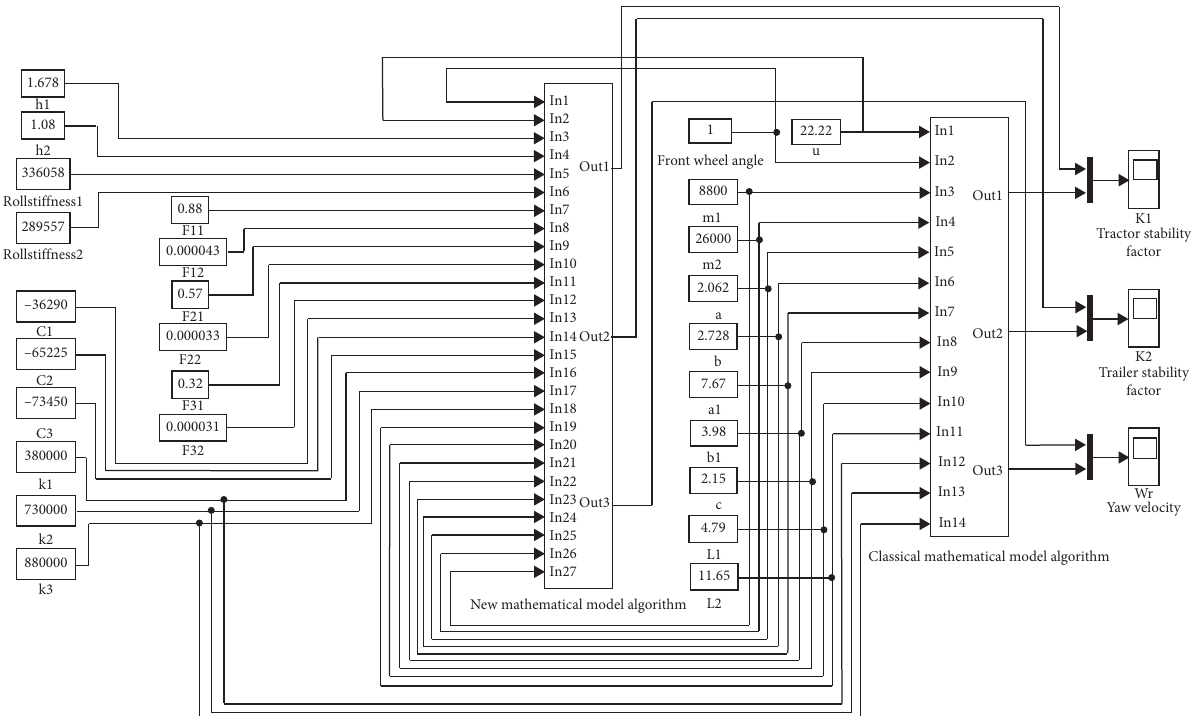
Figure 4: MATLAB solution model of two mathematical models.